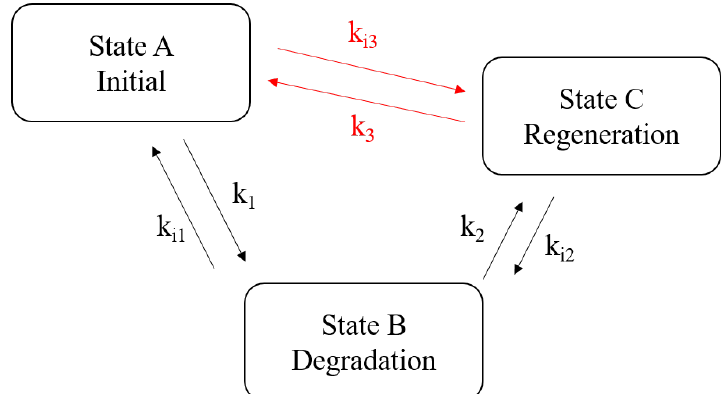
Figure 3. Three-state model structure related to light-induced degradation (LID) and regeneration of a solar